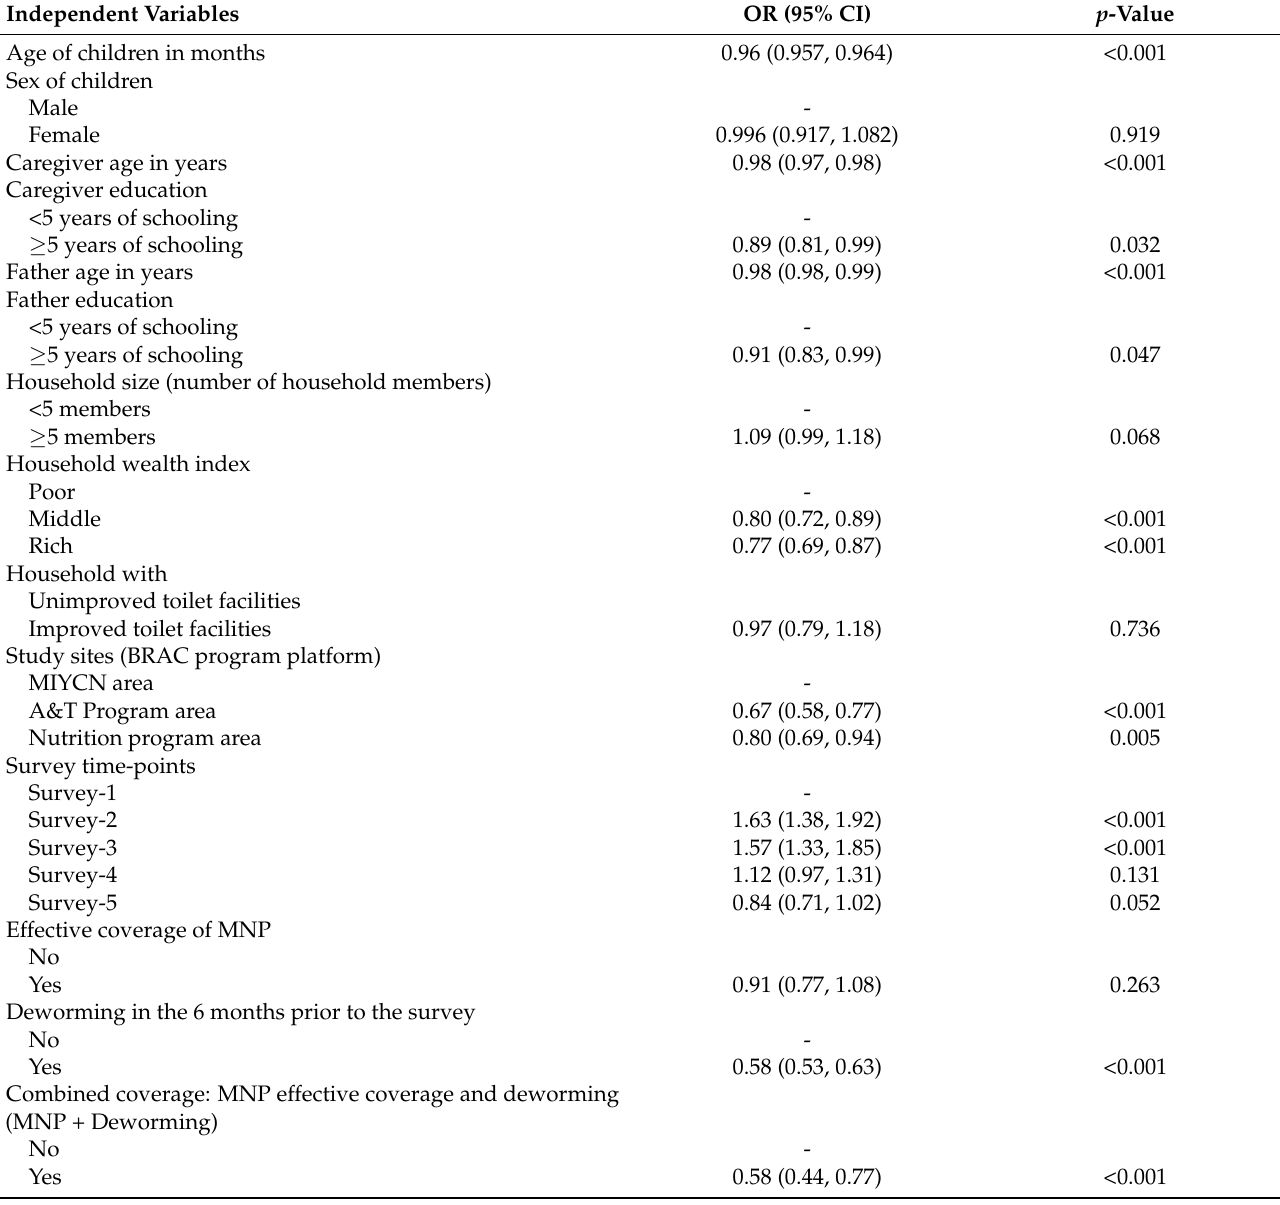
Table 3. Unadjusted odds ratio to assess effects of socio-demographic variables, combined coverage of deworming, and MNP coverage on the prevalence of